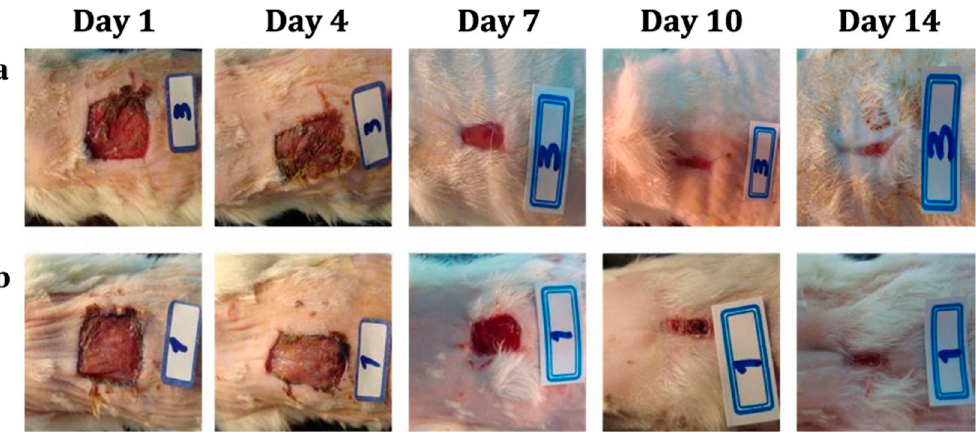
Figure 4. In vivo test on the back of the rats. ( a ) Blank chitosan/PEO nanofiber, ( b ) chitosan/PEO nanofiber containing 2 wt% L. inermis [160].